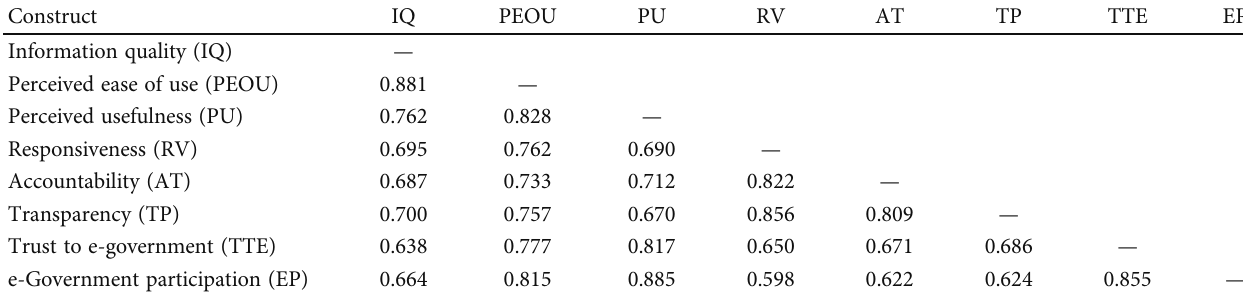
Table 5: Heterotrait-monotrait ratio (HTMT).